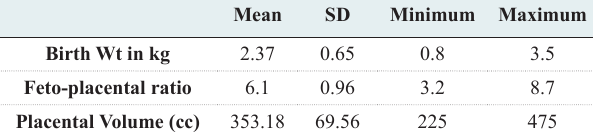
Table 5: Fetal weight and Feto-Placental